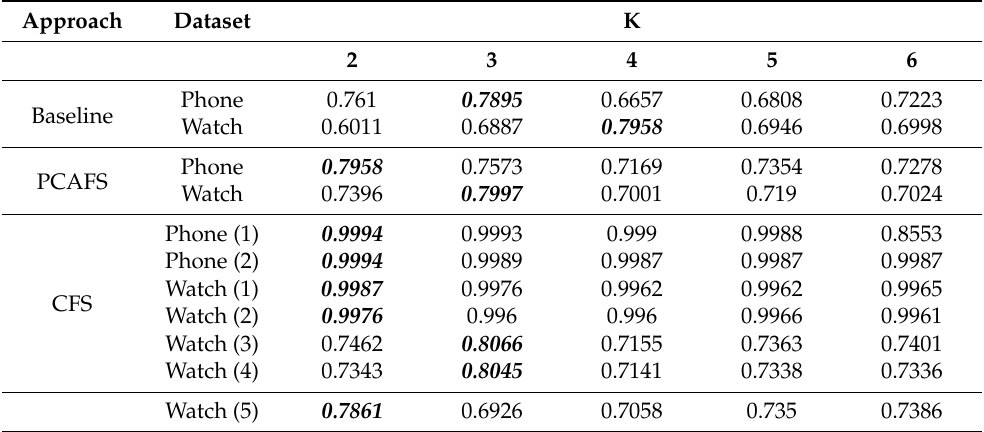
Table 4. Silhouette averages for the Phone and Watch datasets for the baseline, PCAFS, and CFS datasets. The bold and italic values denote the value of k to select for each dataset, as these provide the largest silhouette